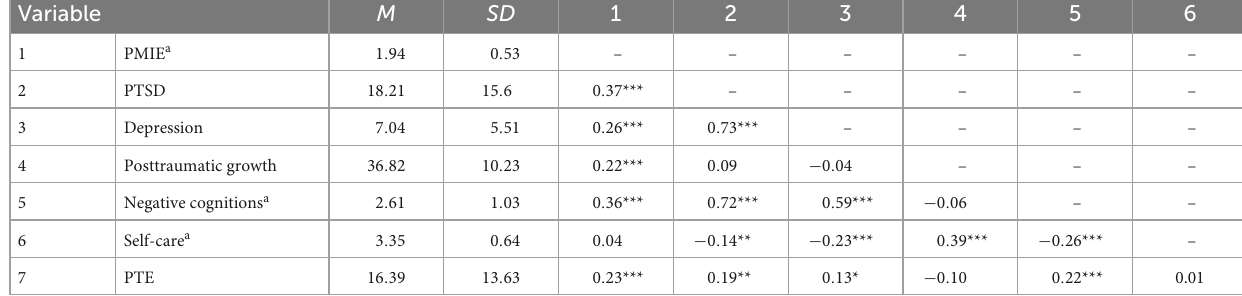
TABLE 1 Descriptive statistics and correlations for study